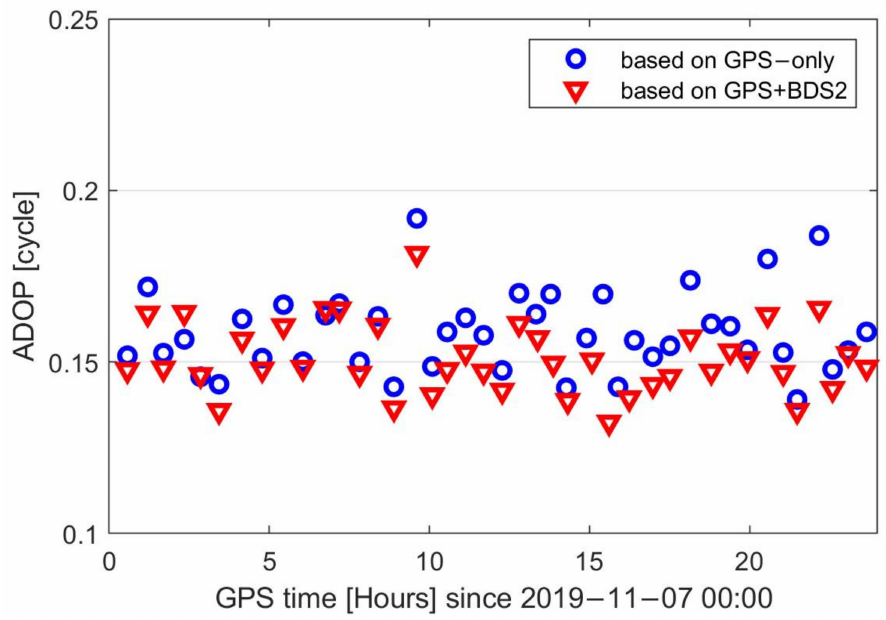
Figure 15. GPS ambiguity dilution of precision (ADOP) on DOY 311 in 2019.